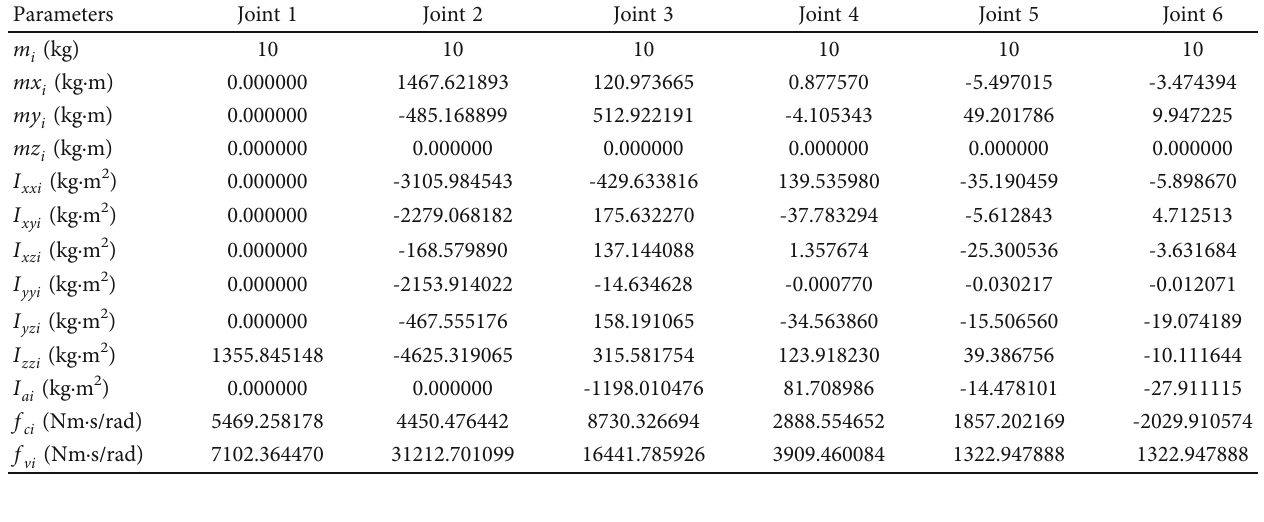
Table 2: Estimated dynamic parameters of the robot.